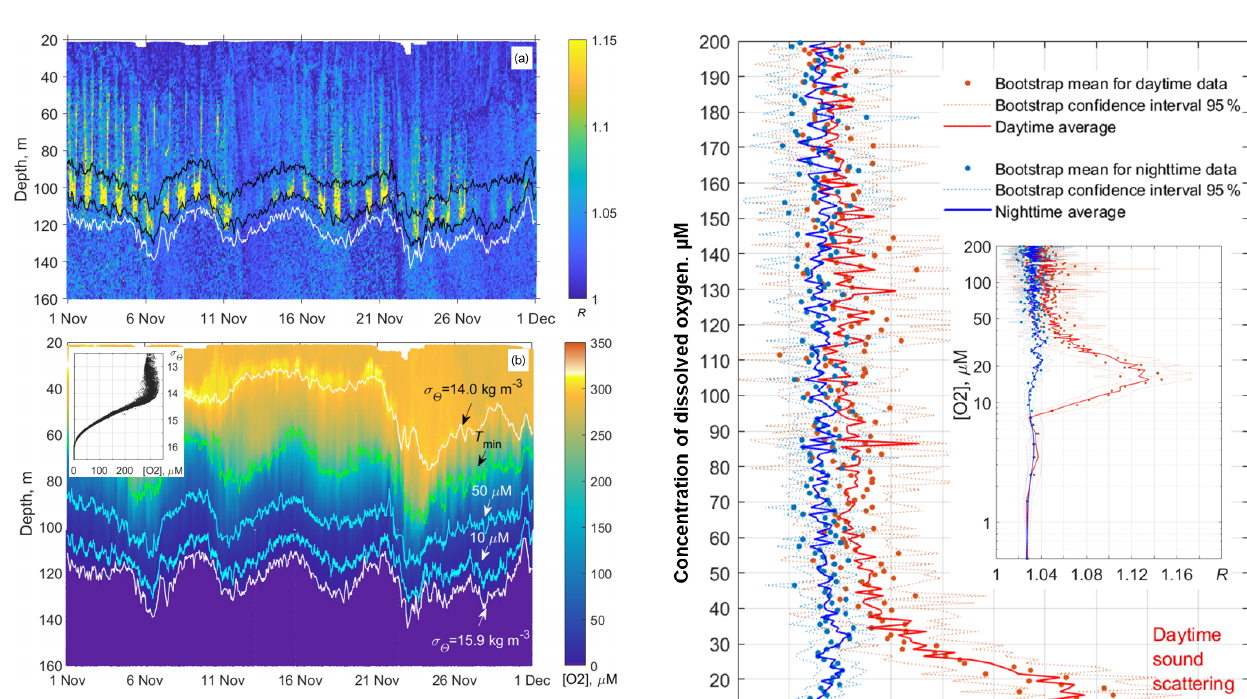
Figure 12. (a) Example of the monthly long time series of the vertical profiles of the directional acoustic backscatter ratio R for November 2019 (in total 960 profiles from the moored profiler sur- vey). The upper and lower black lines are isooxylines of 50 and 10µm, respectively. The white line indicates isopycnal σ (cid:50) = 15.9. (b) Evolution of the dissolved oxygen at the profiler mooring site in November 2019. The colored lines indicate the following: the depths of the isopycnals σ (cid:50) = 14 and 15.9 (top and bottom white lines); the depth of the temperature minimum (green line); and [O 2 ] = 50 and 10µm (blue lines). The inset shows the diagram of the concentration of dissolved oxygen vs. the potential den- sity, [O 2 ] − σ (cid:50) , plotted from the moored profiler data of November